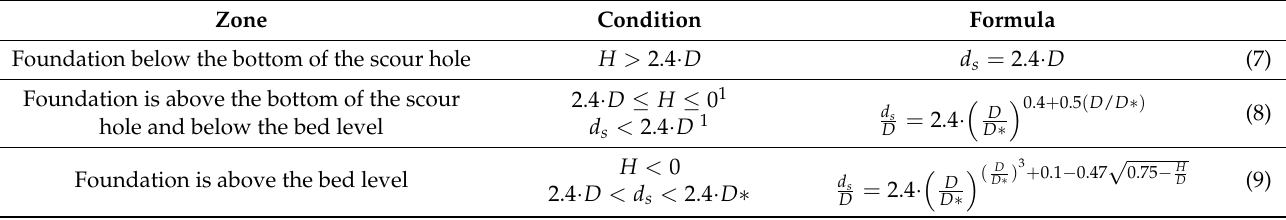
Table 2. Scour depth formula around complex piers based on influence of the top of the foundation.